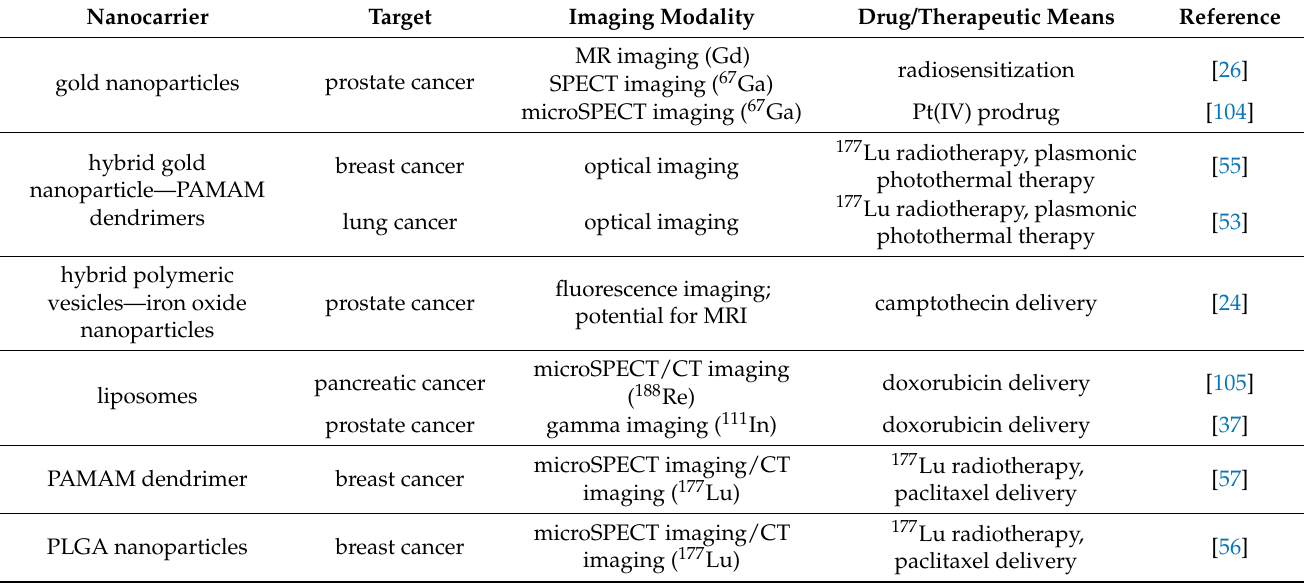
Table 3. Contemporary GRPR-targeted nanosystems for cancer